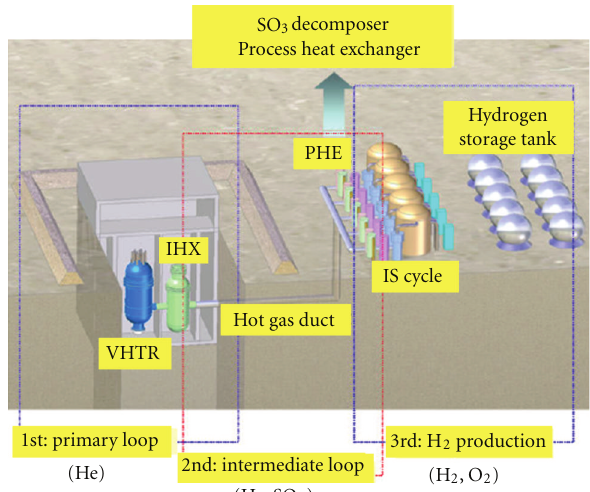
Figure 1: Nuclear hydrogen system.